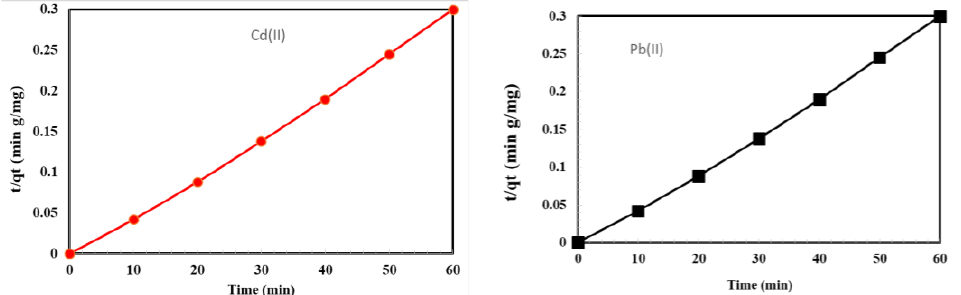
Figure 10. Pseudo-second order kinetic models for the adsorption of Pb 2+ and Cd 2+ on BI@MWCNTs (conditions: pH, 5.0; initial adsorbed concentration, 50 mg/L; adsorbent dose, 4 mg; temperature, 25 °C). Table 3. The kinetic model parameters and determination coefficients for Pb 2+ and Cd 2+ adsorption on prepared BI@MWCNTs.